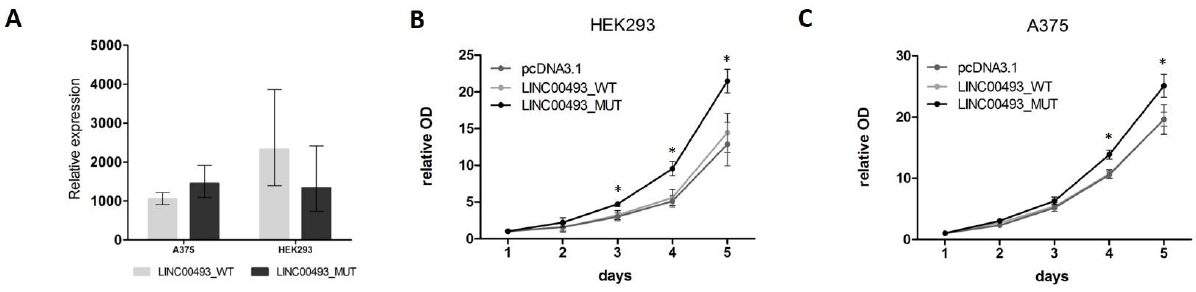
Figure 4. Influence of LINC00493/SMIM26 overexpression on cell viability. ( A ) LINC00493_WT and LINC00493_MUT overexpression efficiency in A375 and HEK293 cell lines. ( B , C ) Relative optical density value of HEK293 and A375 cells treated by LINC00493_WT, LINC00493_MUT and control cells in the MTT assay. Cells with overexpression of mutated LINC00493 showed higher viability than those transfected with WT LINC00493 or empty pcDNA3.1 vectors. Error bars represent the mean ± SEM (standard error mean) of three independent experiments. * p < 0.01, vs. control (according to Mann – Whitney U test).